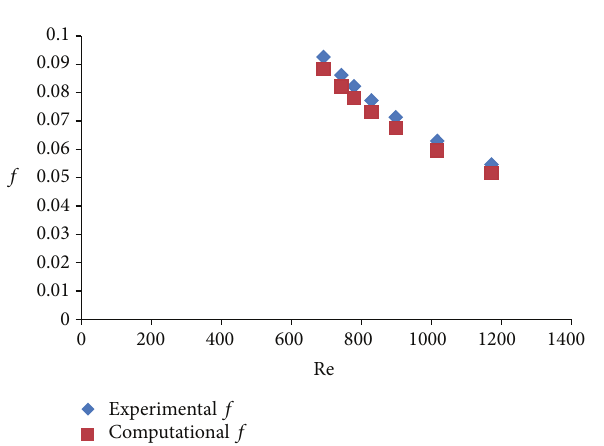
Figure 6: Friction factor versus Reynolds number for 0.87 mm ID- tube and 2% Al 2 O 3 -water nanofluid.